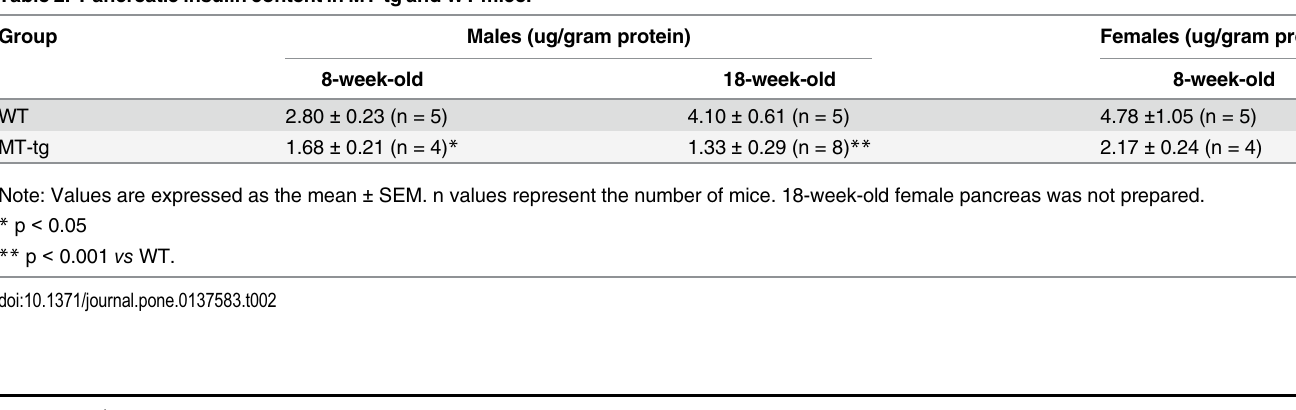
Insulin secretion in islets of MT-tg mice To determine the impact of MT-tg overexpression on insulin release, insulin secretion was assayed in islets isolated from 8-week-old MT-tg and WT mice. The results showed that MT-tg islets didn ’ t response to high glucose stimulation (16.7 mM) and had significant reduction in insulin secretion compared with WT mice (Fig 4A and 4B). The reduction was also observed in Table 2. Pancreatic insulin content in MT-tg and WT mice. Group